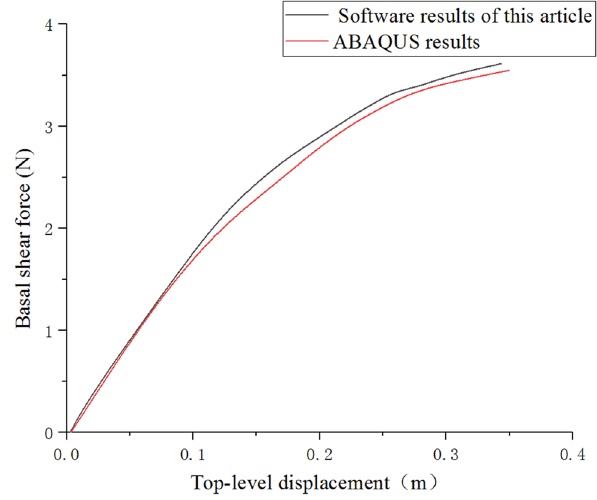
Figure 6: Load displacement curve.